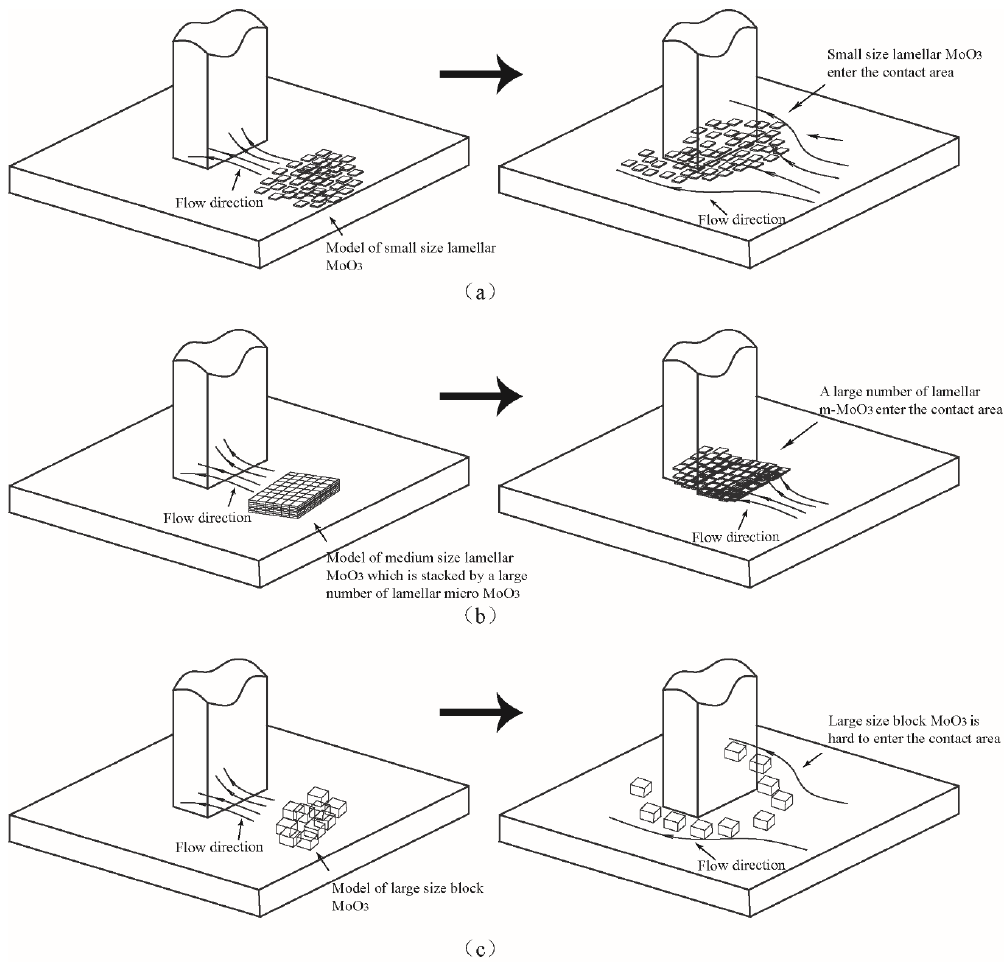
Figure 17. Schematic diagrams of the influence of different sizes of MoO 3 on friction: ( a ) small-sized lamellar MoO 3 , ( b ) medium-sized lamellar MoO 3 , and ( c ) large-sized block MoO 3 .